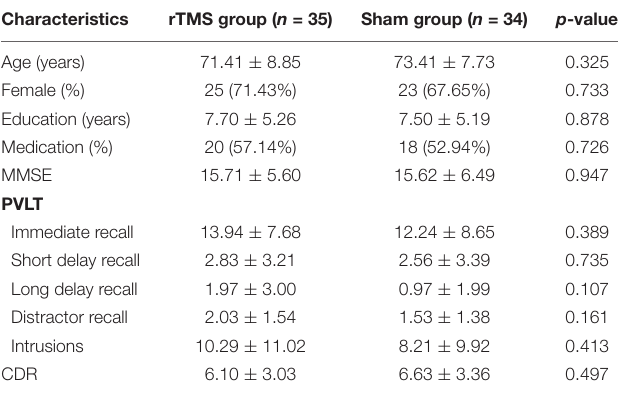
TABLE 1 | Baseline characteristics of AD patients.